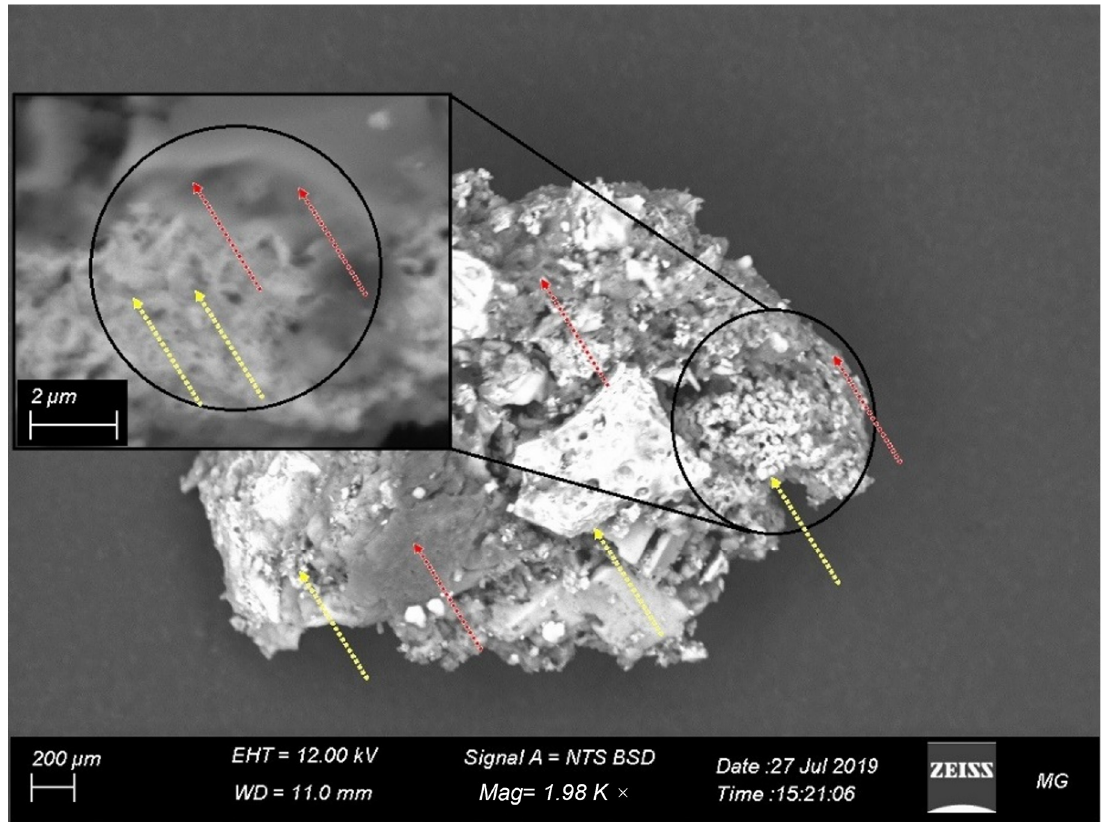
Figure 5. FE-SEM image of the synthesized alpha-amylase doped on chitosan-loaded barium ferrite nanoparticles. The arrows indicate the porous structure of chitosan-loaded barium ferrite, where alpha-amylase is deposited.